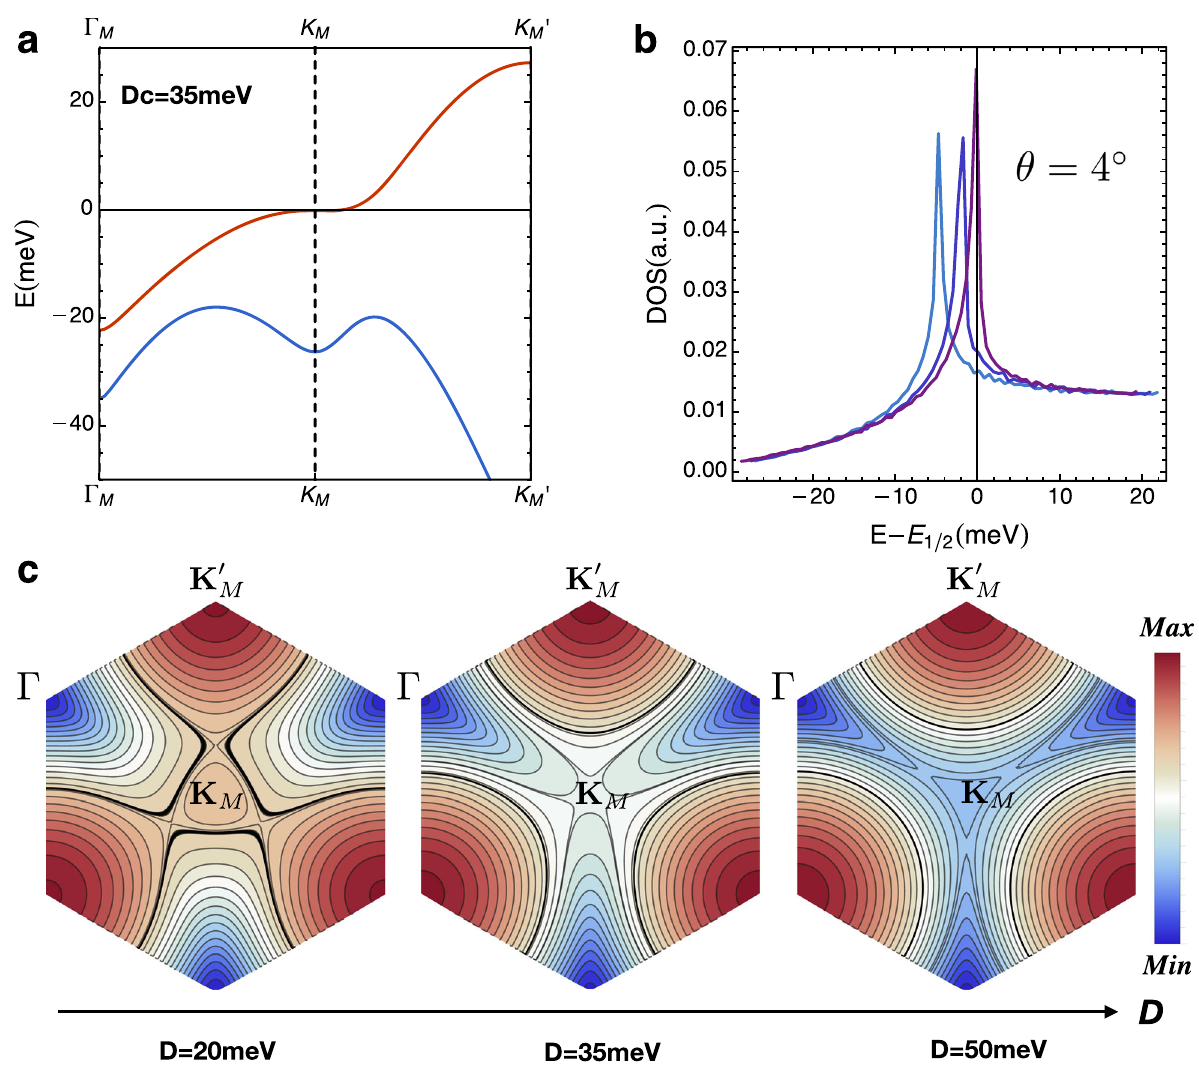
Fig. 1 Moiré band structures. a The moiré band structure for one valley of twisted bilayer WSe 2 . At a critical displacement fi eld D c ≅ 35 meV, the K M becomes a saddle point of the dispersion. b The density of states (with various D near D c ) at twist angle θ = 4°. c Evolution of energy contours of the topmost moiré band as a function of the displacement fi eld (the dark line corresponds to half- fi lling). At D c , the system hosts a higher-order van Hove singularity at K M